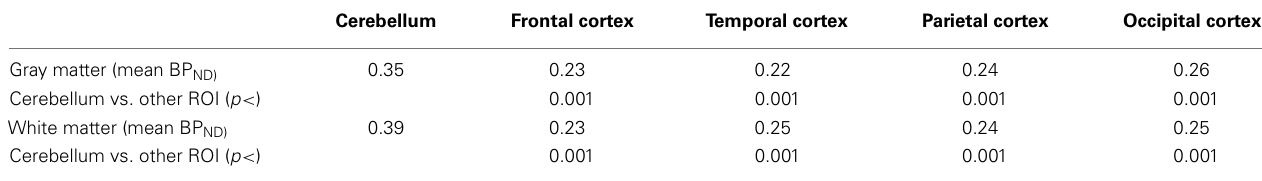
Table 2 | Mean BP ND for [ 11 C]PiB in different ROI determined by the Hypotime method for gray and white matter in the CCD group. Cerebellum Frontal